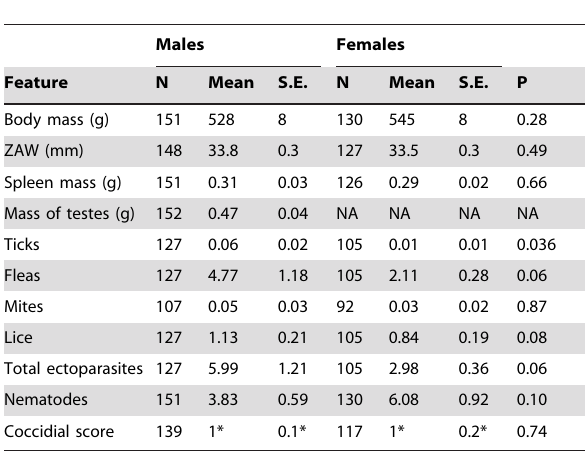
Table 2. Sex differences in morphology and parasitism.